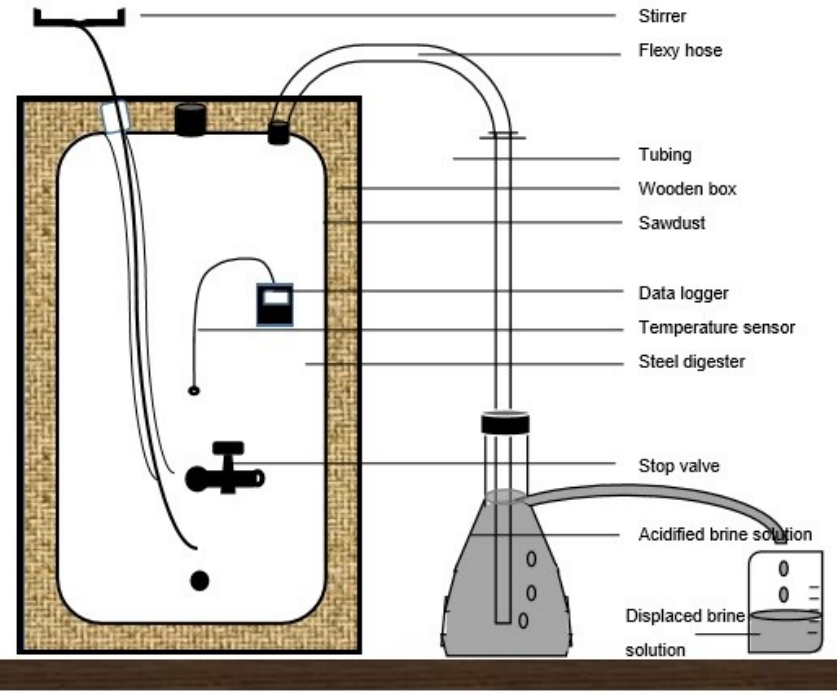
Figure 1. A display of the biodigesting chamber and other components.